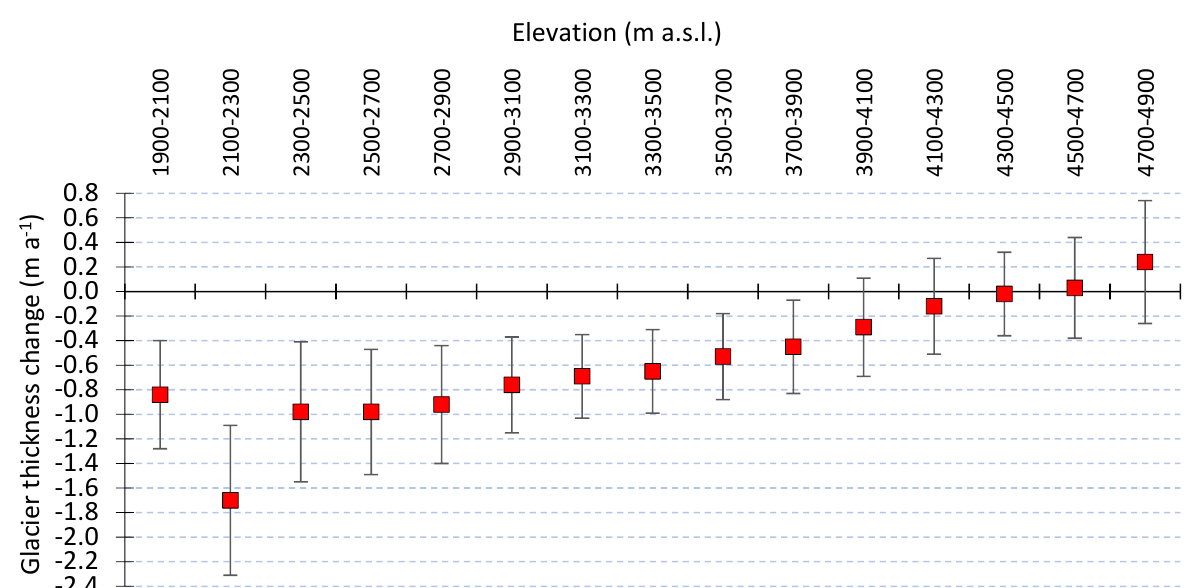
Figure A1. Change in in glacier thickness or surface elevation (m a − 1 ) as a function of glacier mean elevation (m a.s.l.) in the Greater Caucasus between 2000 and 2019. Elevation bands in 200 m. Vertical stems show an uncertainty estimation of the mean values.